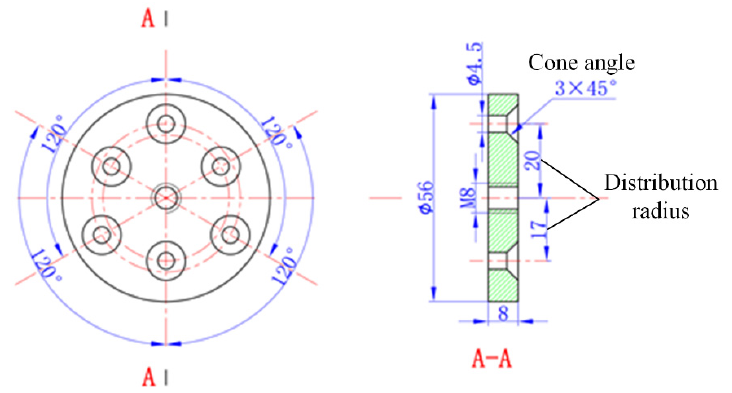
Figure 21. Design of ball ‐ and ‐ socket disc.